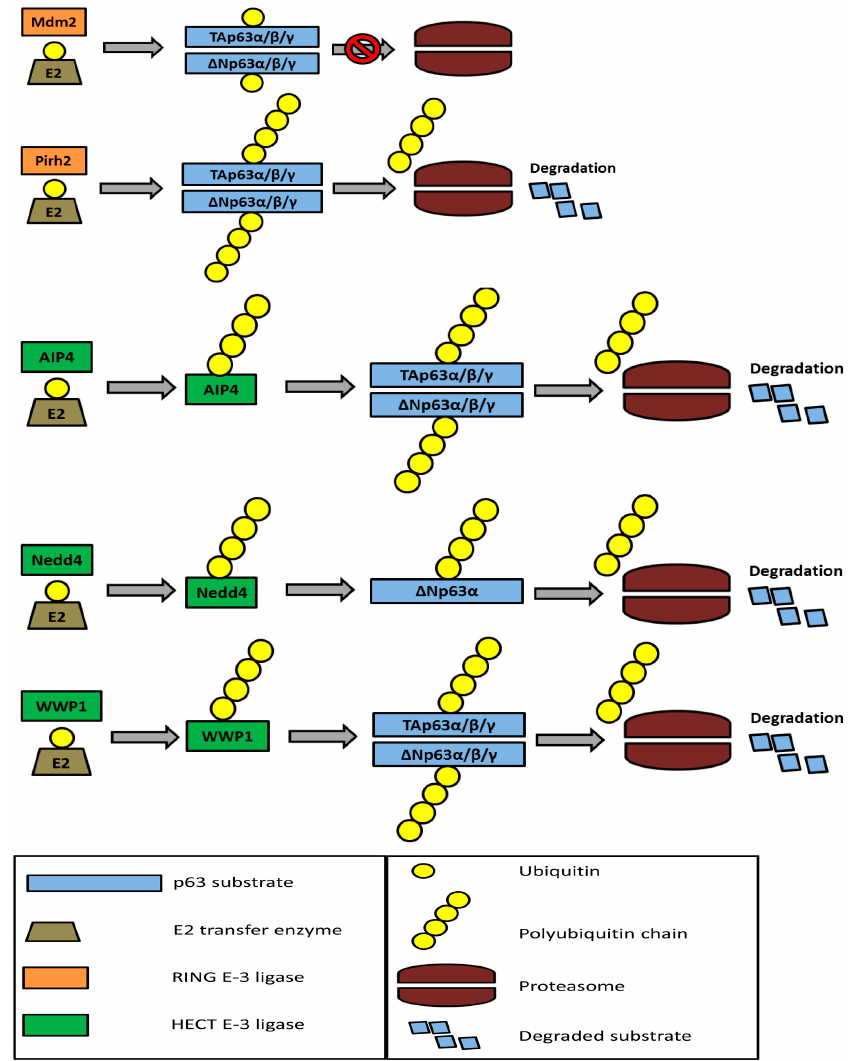
Figure 2. Overview of the regulation of p63 isoforms. This figure outlines the different ubiquitin E3-ligases regulate p63 isoforms and how they interact with the p63 isoforms and subsequent proteasome degradation.